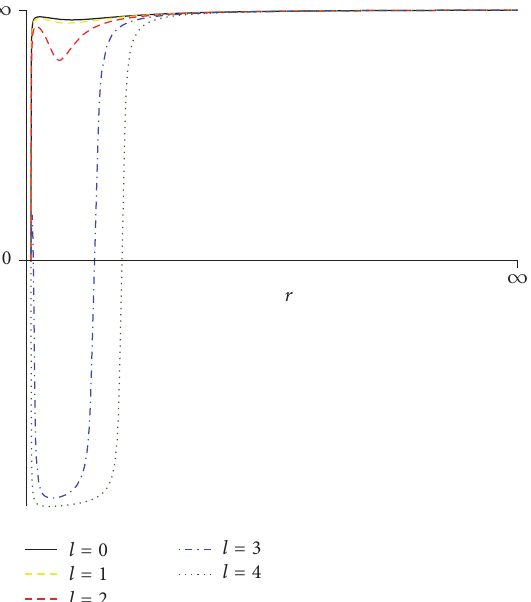
Figure 7: The potential 𝑉 in function of 𝑟 , from 𝑟 ℎ = 0.459413 to ∞ for 𝛼 0 = 0.677 , 𝑀 = 1 , and 𝜇 = 0